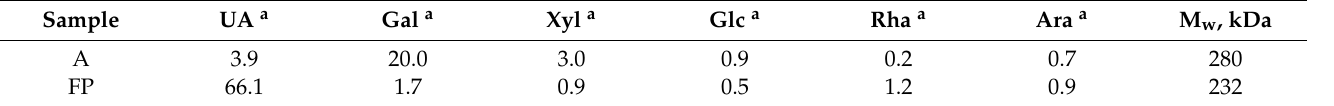
Table 5. Chemical characteristics of polysaccharides